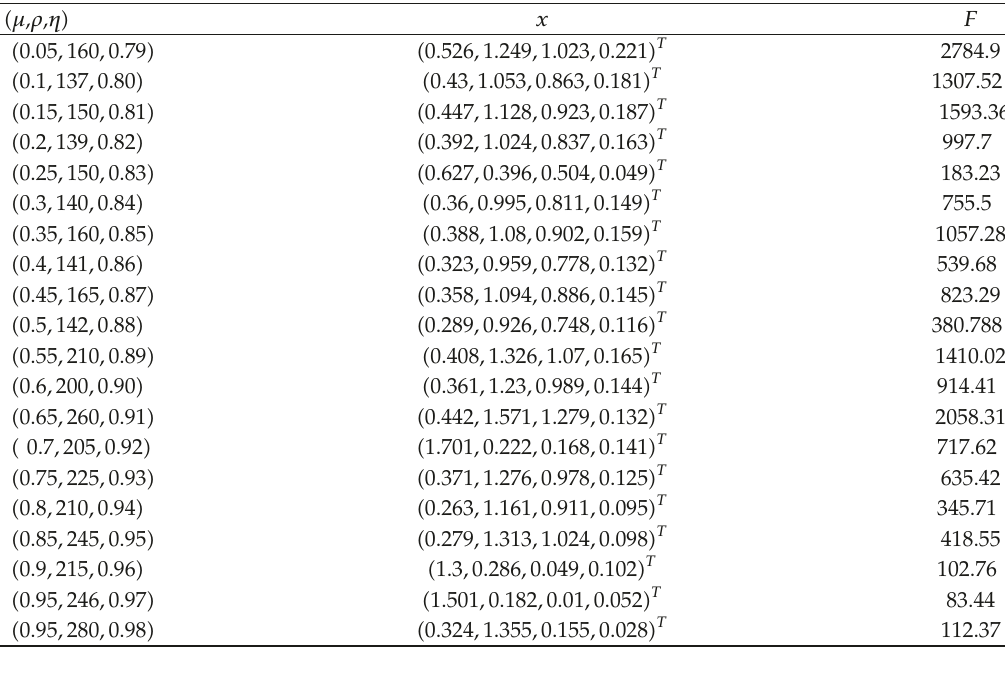
Table 1: E ff ects of the three-level parameters on